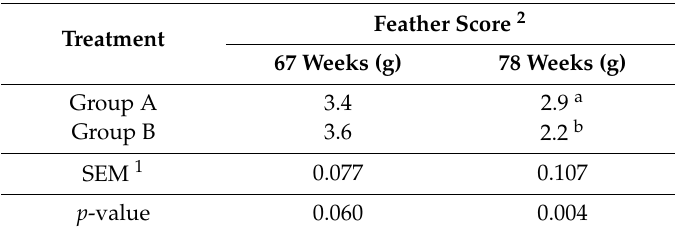
Table 9. Feather condition score of laying hens fed a commercial diet (Group A) or a soy-free diet + live larvae (Group B) from 67 to 78 weeks of age.